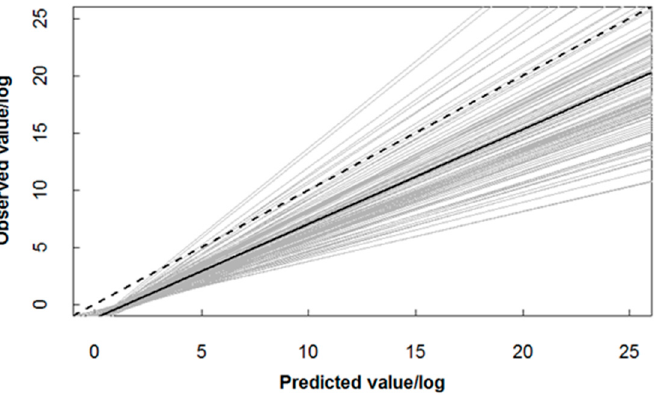
Figure 2. Linear regression lines for the models from averaging 100 runs of cross-validations (the light gray solid lines are 100 linear regression lines, the black solid line is the mean of cross-validation results, and the black dashed line is the 1:1 line).